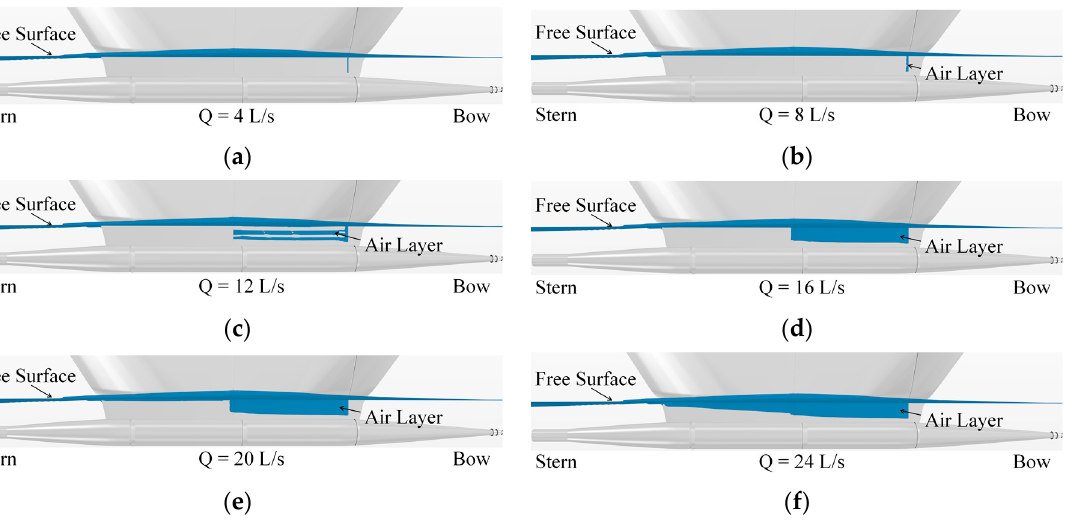
Figure 11. Air layer distribution with air injected from location L5: ( a ) Air fl ow rate Q = 4 L/s; ( b ) Air fl ow rate Q = 8 L/s; ( c ) Air fl ow rate Q = 12 L/s; ( d ) Air fl ow rate Q = 16 L/s; ( e ) Air fl ow rate Q = 20 L/s; ( f ) Air fl ow rate Q = 24 L/s.